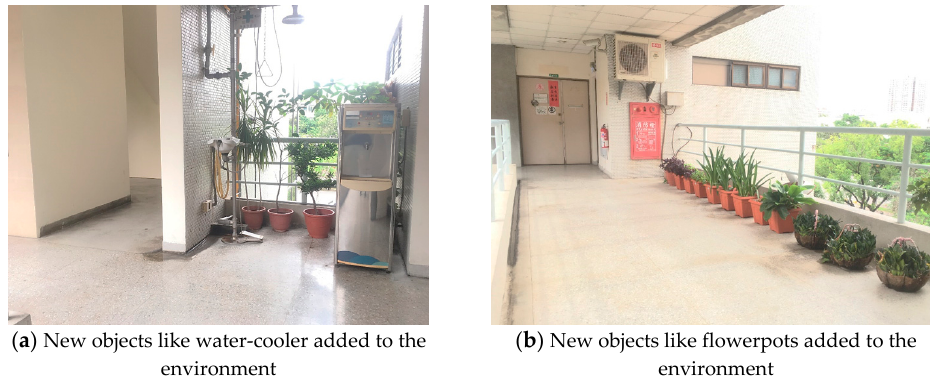
Figure 14. DAA-3F local snapshot with new objects to test the robustness of the algorithm. In the experiment, the traveling path of the vehicle goes counterclockwise on the 3rd floor. The transient localization behavior can refer to Figure 15, where the upper left subplot and lower left